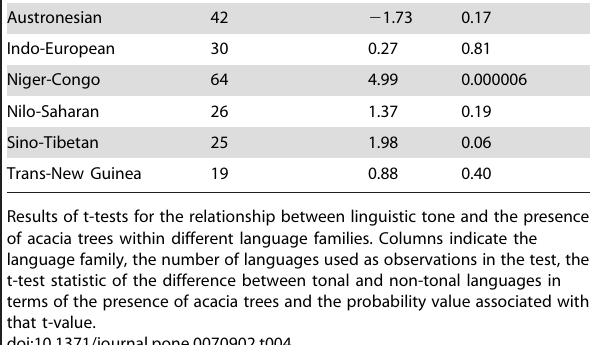
Figure 8. The proportion of tone languages within a country as a function of the presence of Acacianilotica .